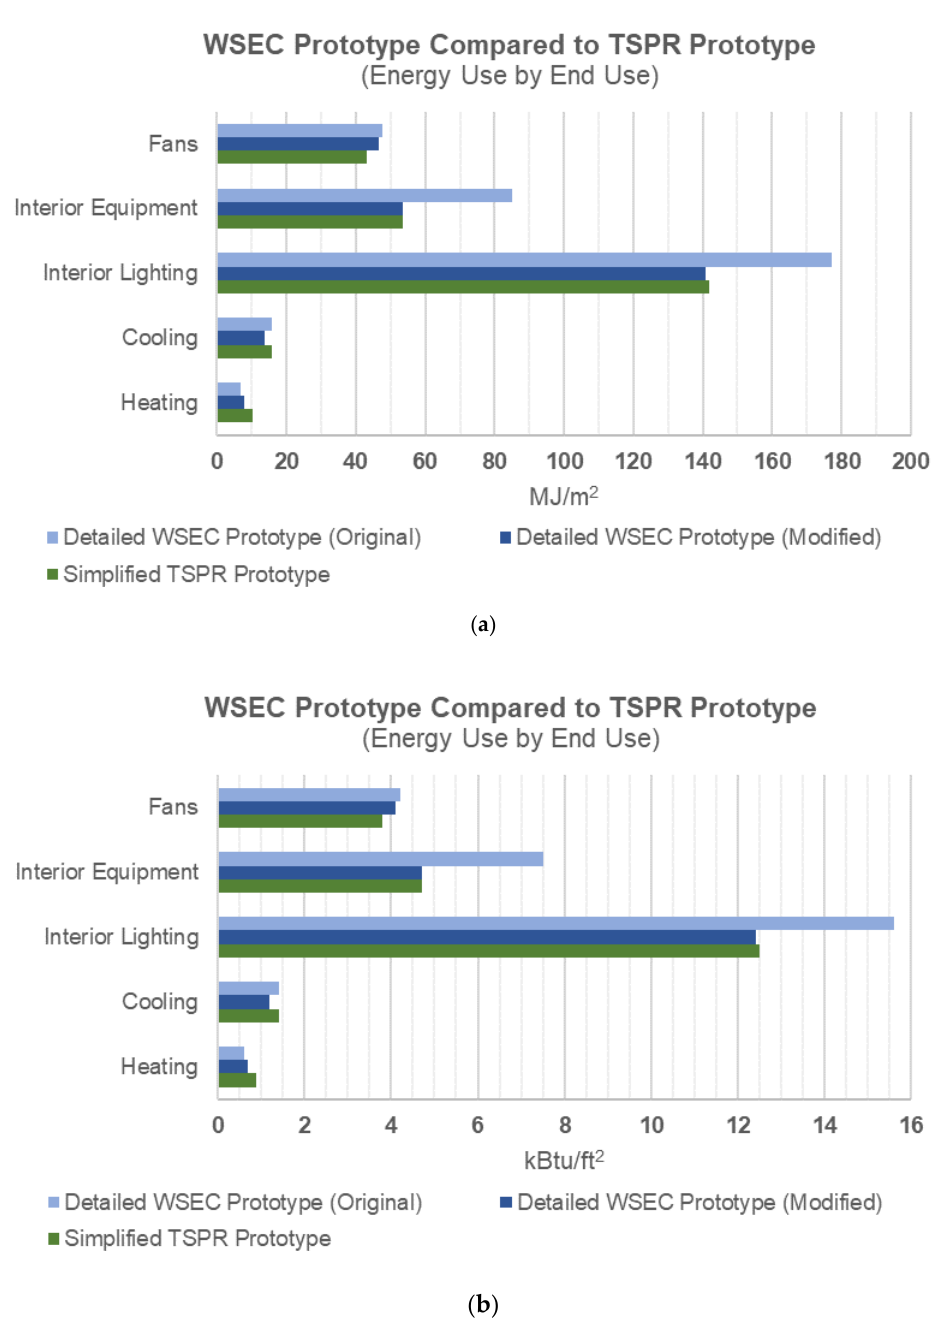
Figure 5. Energy use by end use comparison of the detailed prototype versus simplified TSPR model. ( a ) SI units; ( b ) IP units.